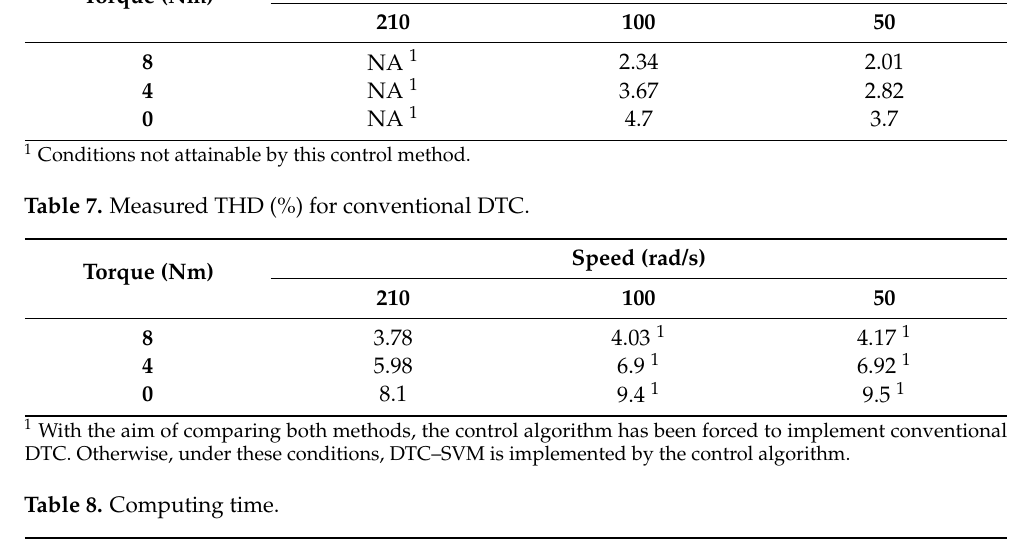
Table 6. Measured THD (%) for DTC–SVM. Torque (Nm)